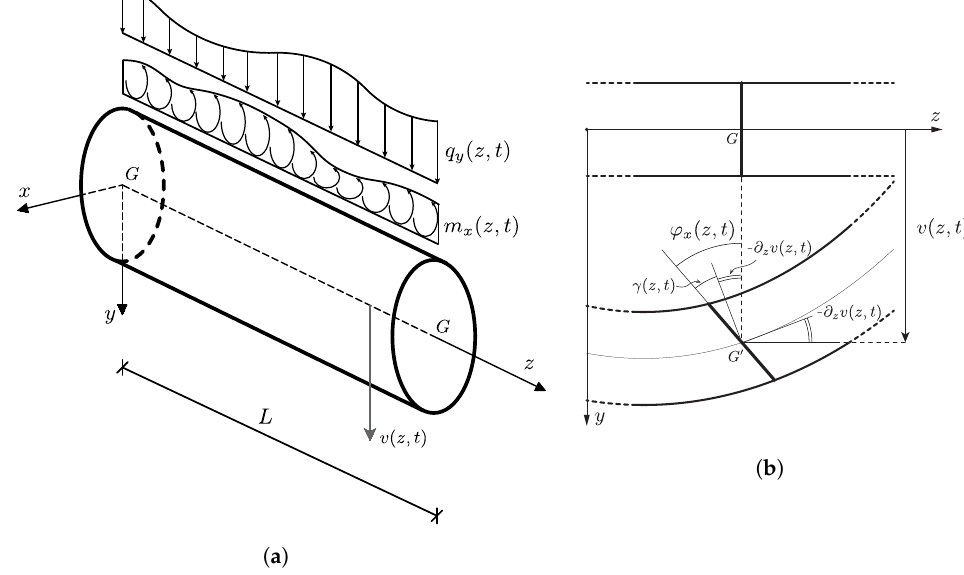
Figure 1. Stubby beam. ( a ) Layout of the beam; ( b ) kinematic